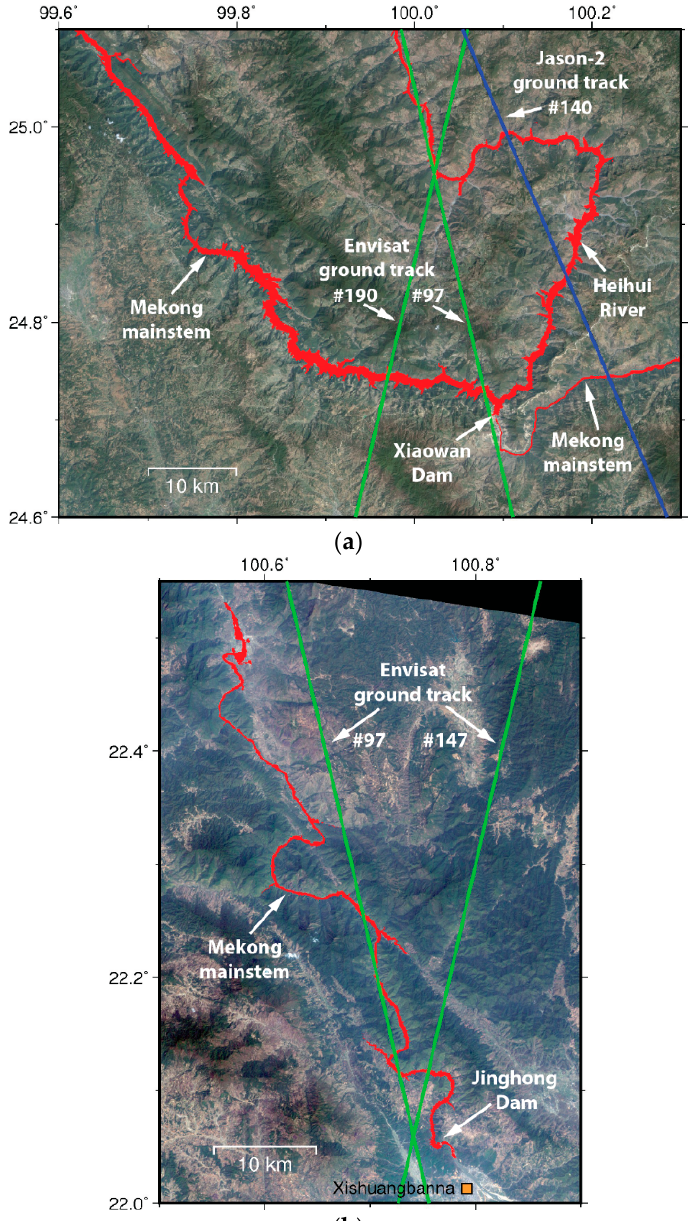
Figure 3. Extracted water surface (red area) of: ( a ) Xiaowan Dam after impoundment; and ( b ) Jinghong Dam after impoundment. The background images are composed by Landsat-7 natural color combination (RGB: band 3, 2, 1). Envisat and Jason-2 ground tracks are denoted by green and blue lines, respectively.